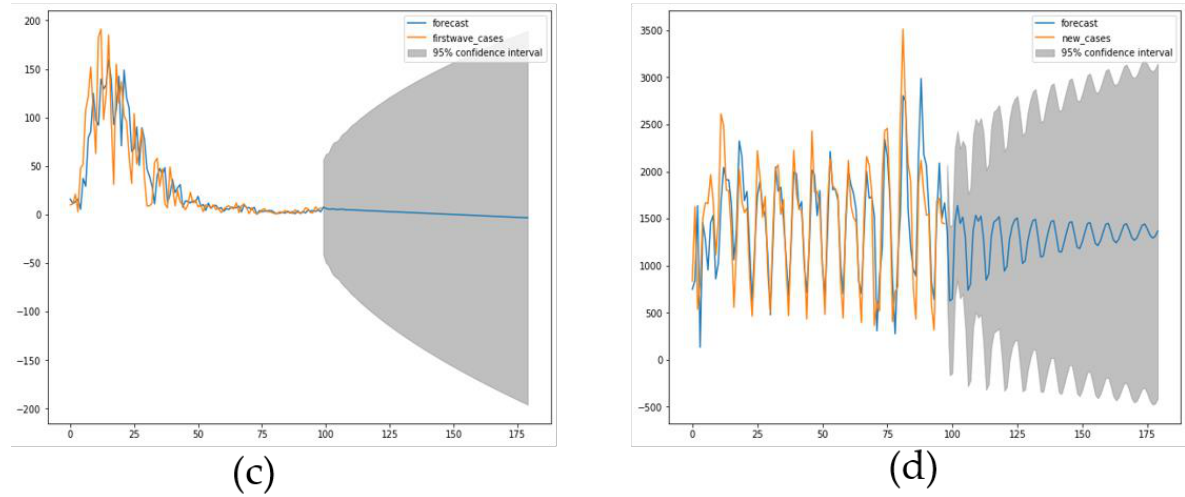
Figure 9. ( a ) First and ( b ) second wave forecast for Mali. ( c ) First wave forecast for Luxembourg. ( d ) Second wave forecast for Slovenia.